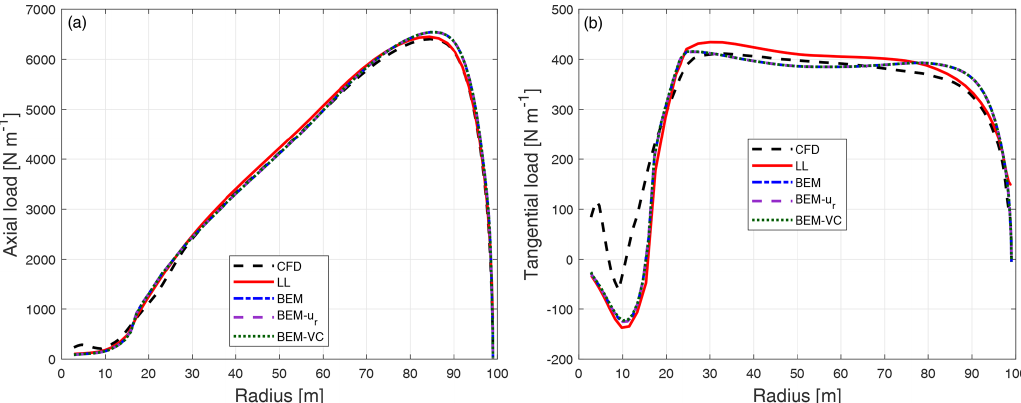
Figure 10. Comparison of axial load (a) and tangential load (b) of the baseline straight blade calculated from CFD, the lifting-line method (LL), the BEM method, BEM with radial induction (BEM- u r ) and the proposed BEM-VC method. The results from three BEM variants coincide with each other as expected.